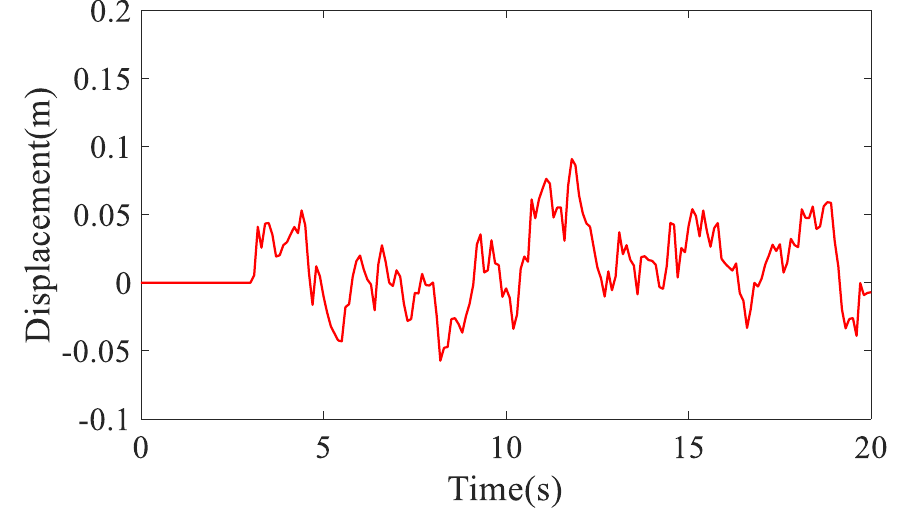
Figure 8. D-level road random time-domain simulation results.